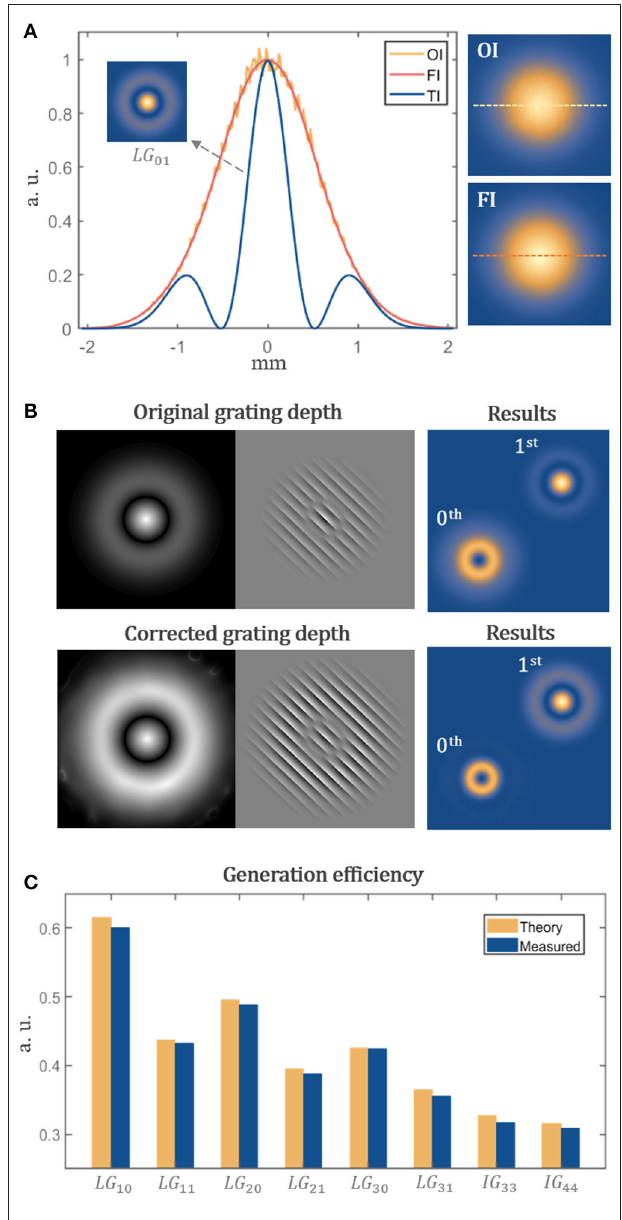
FIGURE 2 | Results of spatial mode generation, (A) characterization of illuminating photons; (B) correction of the hologram for spatial mode generation; (C) generation efficiencies for different spatial modes about the 1st order